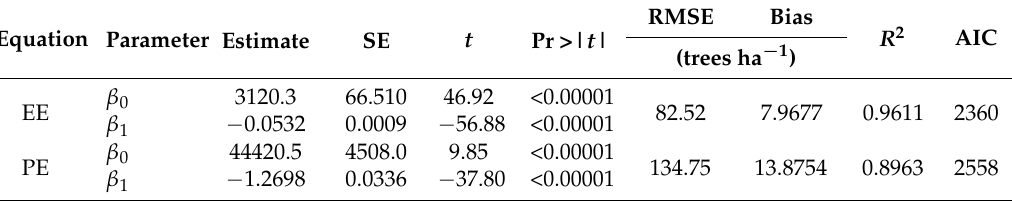
Table 3. Parameter estimates and fitting statistics of the exponential (EE) and potential (PE) equations. Equation Parameter Estimate